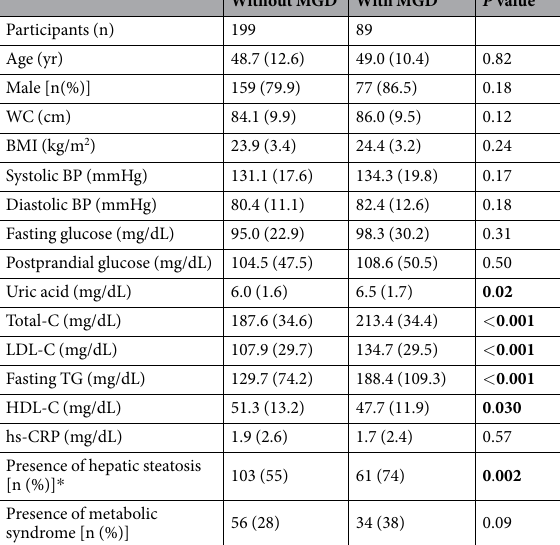
Table 1. Baseline Characteristics and Metabolic Status of Participants with and without Asymptomatic Meibomian Gland Dysfunction. BMI = body mass index; BP = blood pressure; HDL-C = high-density lipoprotein cholesterol; hs-CRP = high-sensitivity C-reactive protein; LDL-C = low-density lipoprotein cholesterol; MGD = meibomian gland dysfunction; TG = triglyceride; Total-C = total cholesterol; WC = waist circumference. * Only 271 out of 288 (total) participants have undergone abdominal ultrasonography for hepatic steatosis. Values are expressed as average (standard deviation). Correlations significant at P < 0.05 are